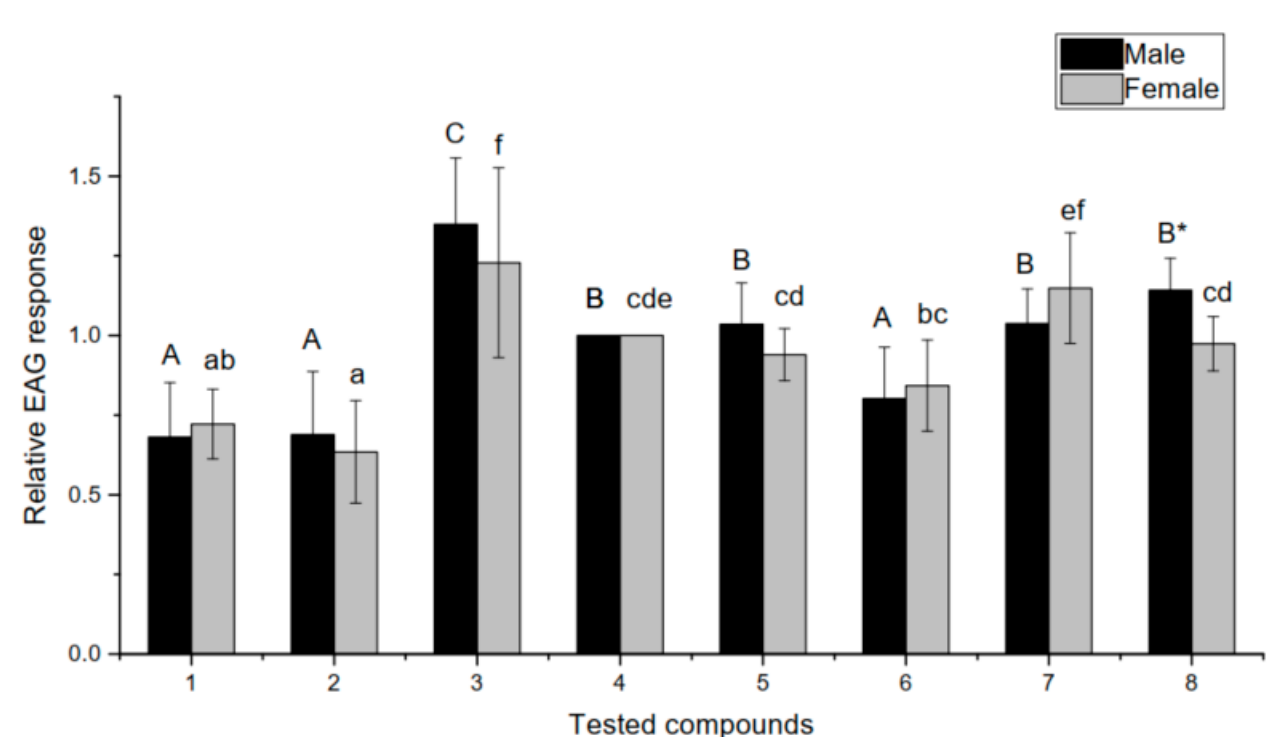
Figure 3. Relative EAG responses of Sclomina erinacea antenna to eight compounds. The Y-axis is the average relative EAG response of the antennae of Sclomina erinacea to eight selected compounds, which are represented by numbers 1–8 on the X-axis: 1 = hexane, 2 = α -pinene, 3 = trans-2-hexenal, 4 = hexanal, 5 = linalool, 6 = β -myrcene, 7 = nonanal, 8 = 1-octen-3-ol. Each insect sex is represented with a unique color, and the data was analyzed using Duncan’s multiple range test within each sex between compounds. The uppercase or lowercase letters on top of each column are placed for the comparison of the EAG responses of males or females to each chemical, the uppercase letters are for males and the lowercase letters are for females. Columns with one or more common letters on top represent there is no significance ( p > 0.05) between the EAG responses of antennae of one sex to each corresponding chemicals, otherwise the EAG responses to each corresponding chemicals for each column(s) with unique letter(s) is(are) significantly different from other chemicals. The symbol * means there is significant difference between the EAG responses of males and females to a chemical.